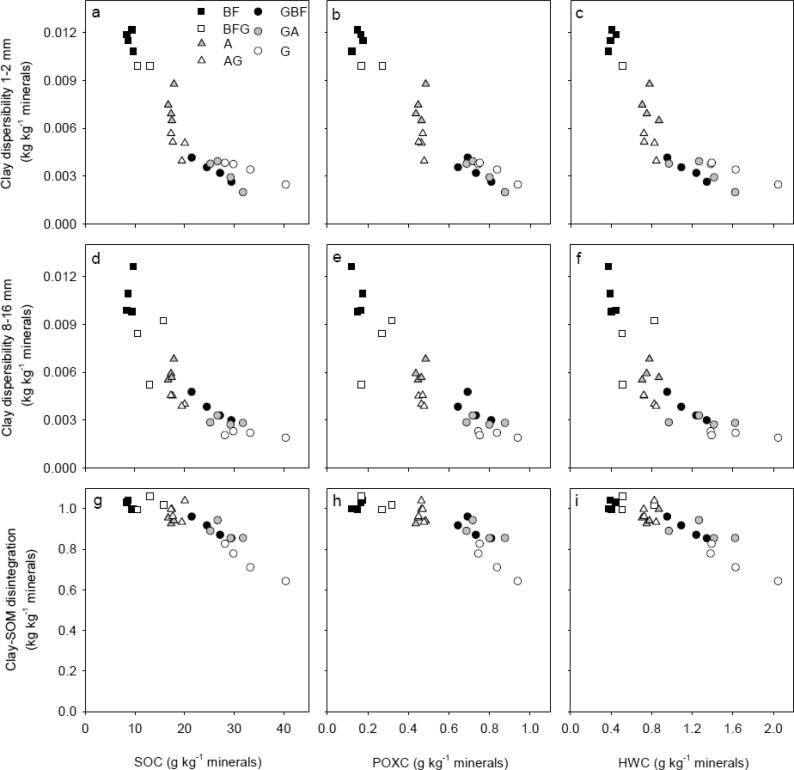
Soil structural stability measures plotted against soil organic carbon (SOC), permanganate oxidizable carbon (POXC) and hot water-extractable carbon (HWC) for the seven treatments at plot level. White, gray and black symbol fills highlight treatments grass, arable and bare fallow, respectively, at time of sampling. For treatment abbreviations, see Fig. 1.